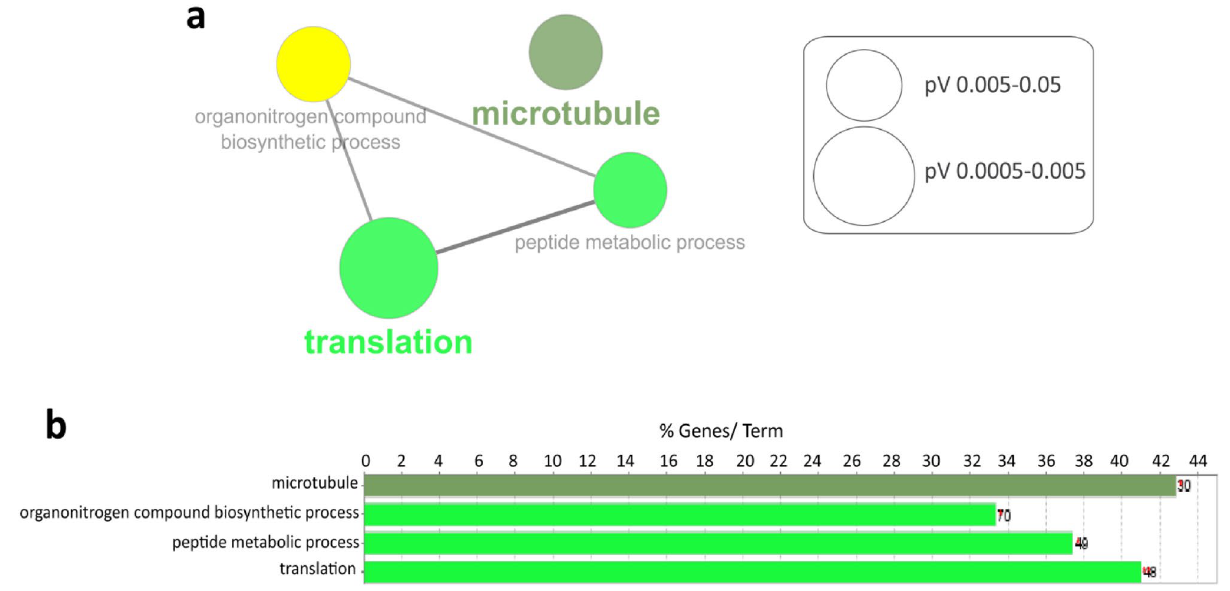
Figure 4. ITM2B interactome in the retina with the 254 proteins purified with the mouse antibody (FC > 2 and p-value < 0.01). ( a ) GO-term network analysis. ( b ) Functional clusters and pathways enriched within the ITM2B interactors. %Genes/Term corresponds to the proportion of genes enriched in the functional clusters. Bars with the same color belong to the same functional